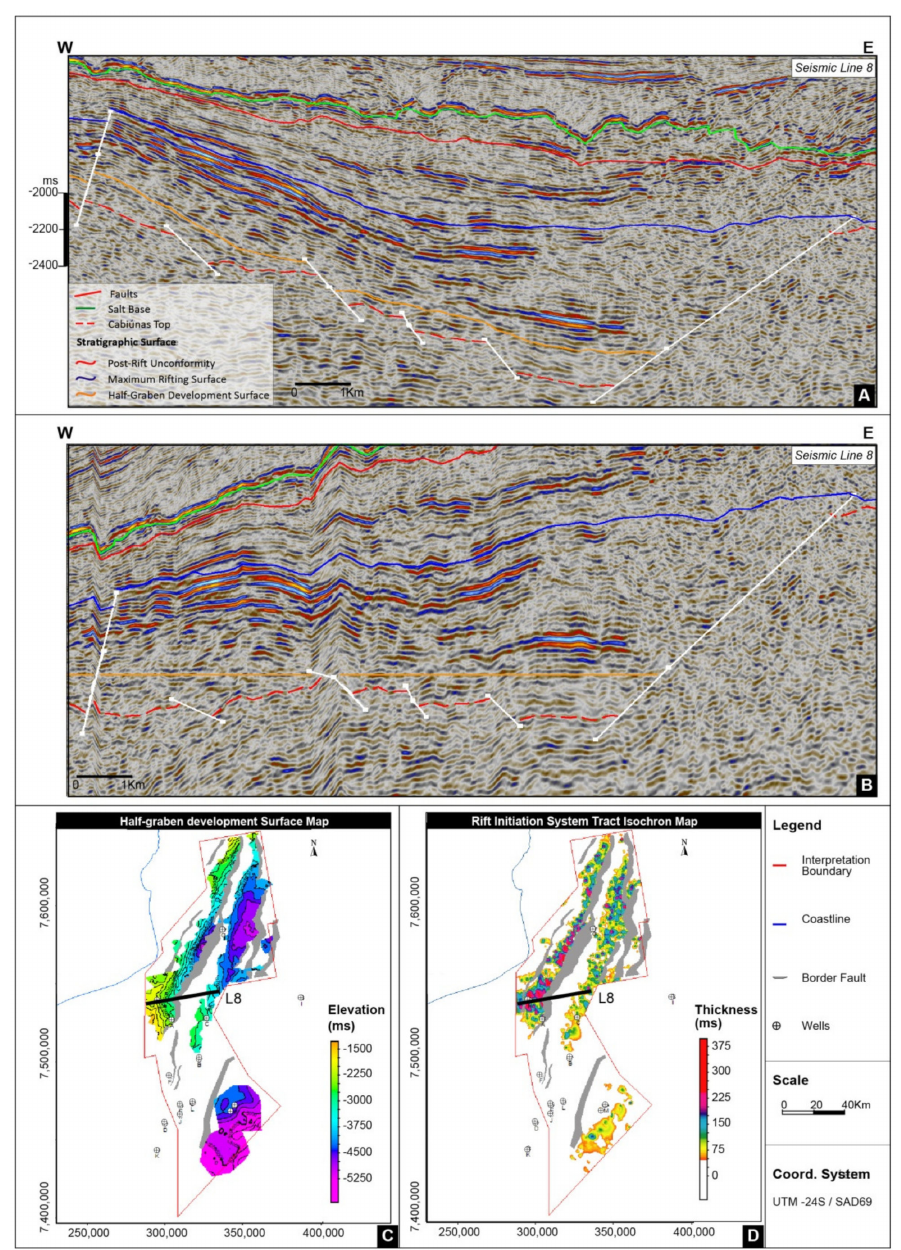
Figure 10. The Rift Initiation Systems Tract (RIST). ( A ) Seismic line 8 shows the structure of the rift initiation section (between orange and red dashed reflectors) and the occurrence of seismic facies 2. ( B ) Seismic line 8 shows the flattening of the half-graben development surface. Observe that all faults (in white) show similar displacement and occur in a general synformal depression configuration during the early section of the rift. ( C ) Isochron map (in seismic time) of the half-graben development surface. ( D ) ‘Isochronpach’ map (thickness in seismic time) of the